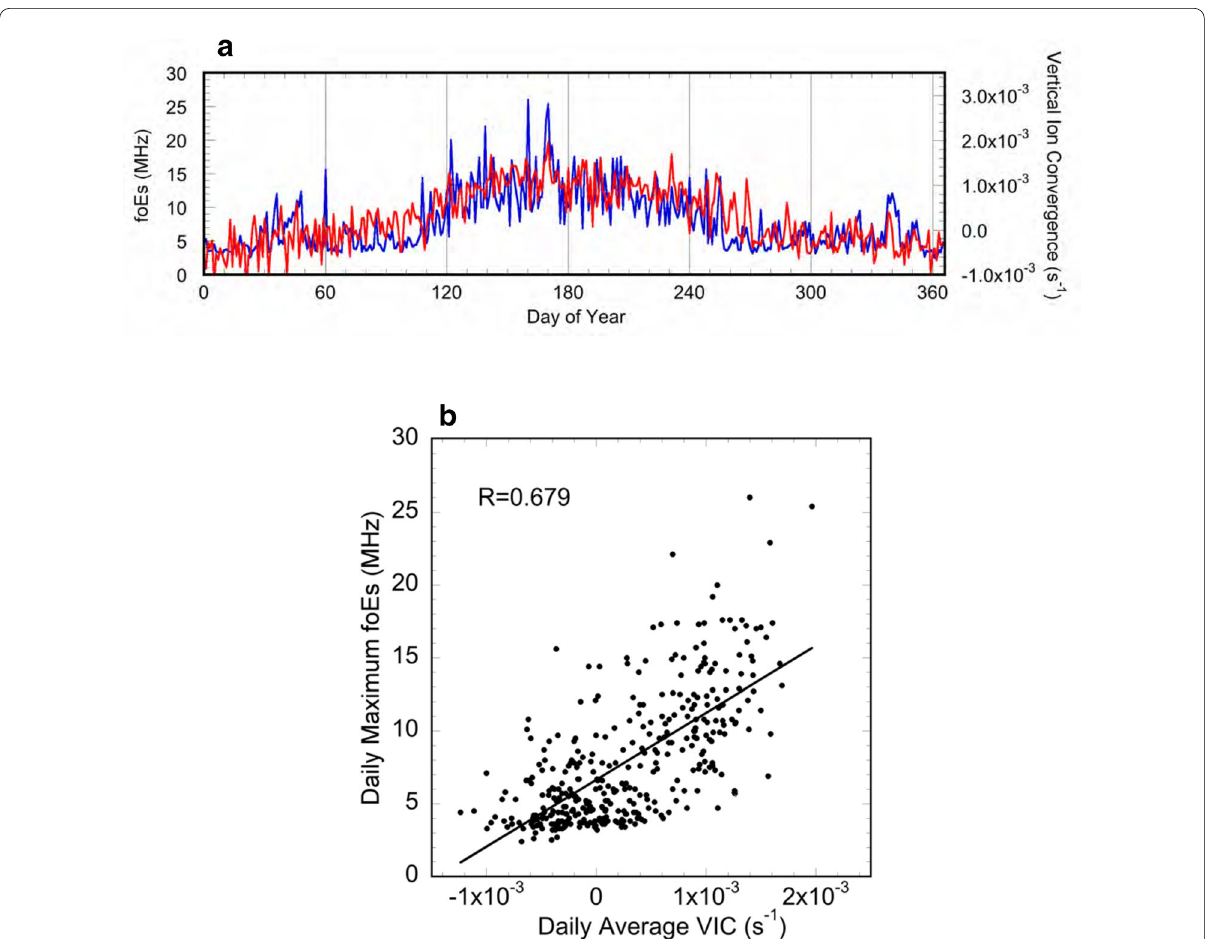
Fig. 9 Daily maximum foEs and daily average VIC 120 . a Daily maximum foE s (blue line) and the daily average vertical ion convergence at 120 km altitude ( VIC 120 ) (red line) at Kokubunji 2009. b Scatter plot and correlation coefficient of the data in